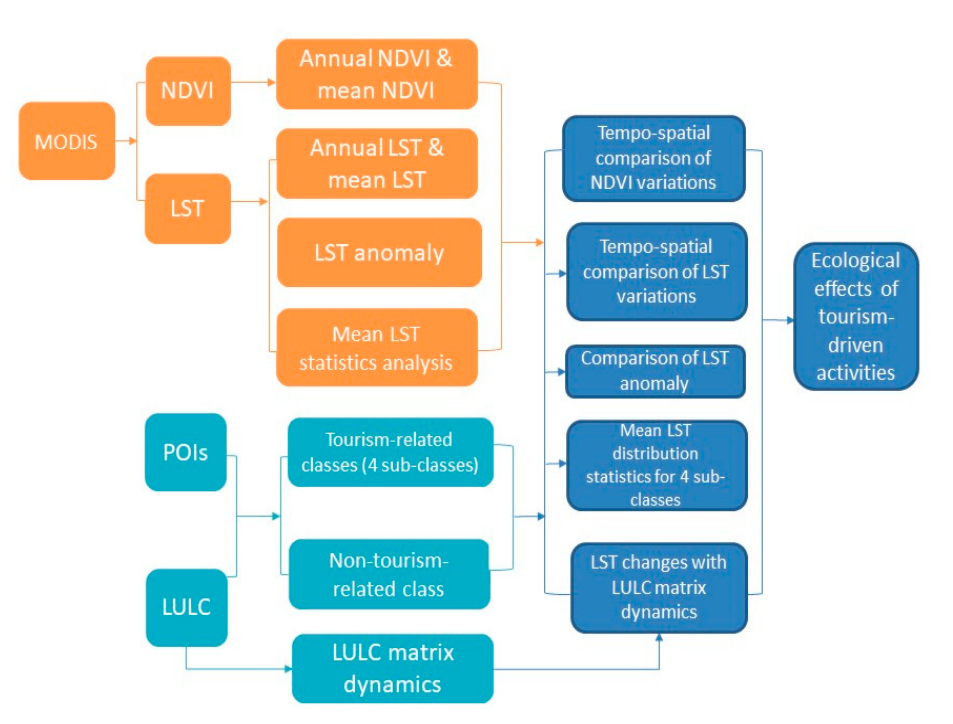
Figure 2. The research workflow (the steps shown in orange are carried out in GEE, and the steps shown in blue with a desktop-based Geographic Information Systems (GIS)